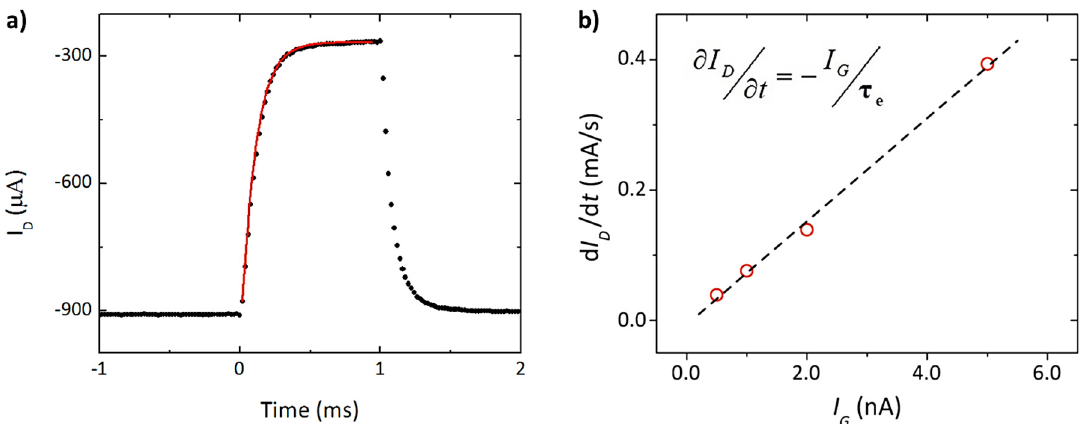
Figure 4. ( a ) Response time ( τ e ) of drain current in an OECT. ( b ) Dependence of temporal drain current ( I D ) on gate current ( I G ). The slope of the linear fitting brings the response time. Edited from Supp. Info. [10] (with permission from Springer Nature).